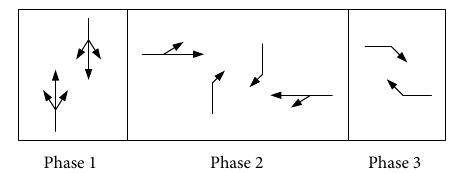
Fig. 2. The phasing diagram for the intersection with